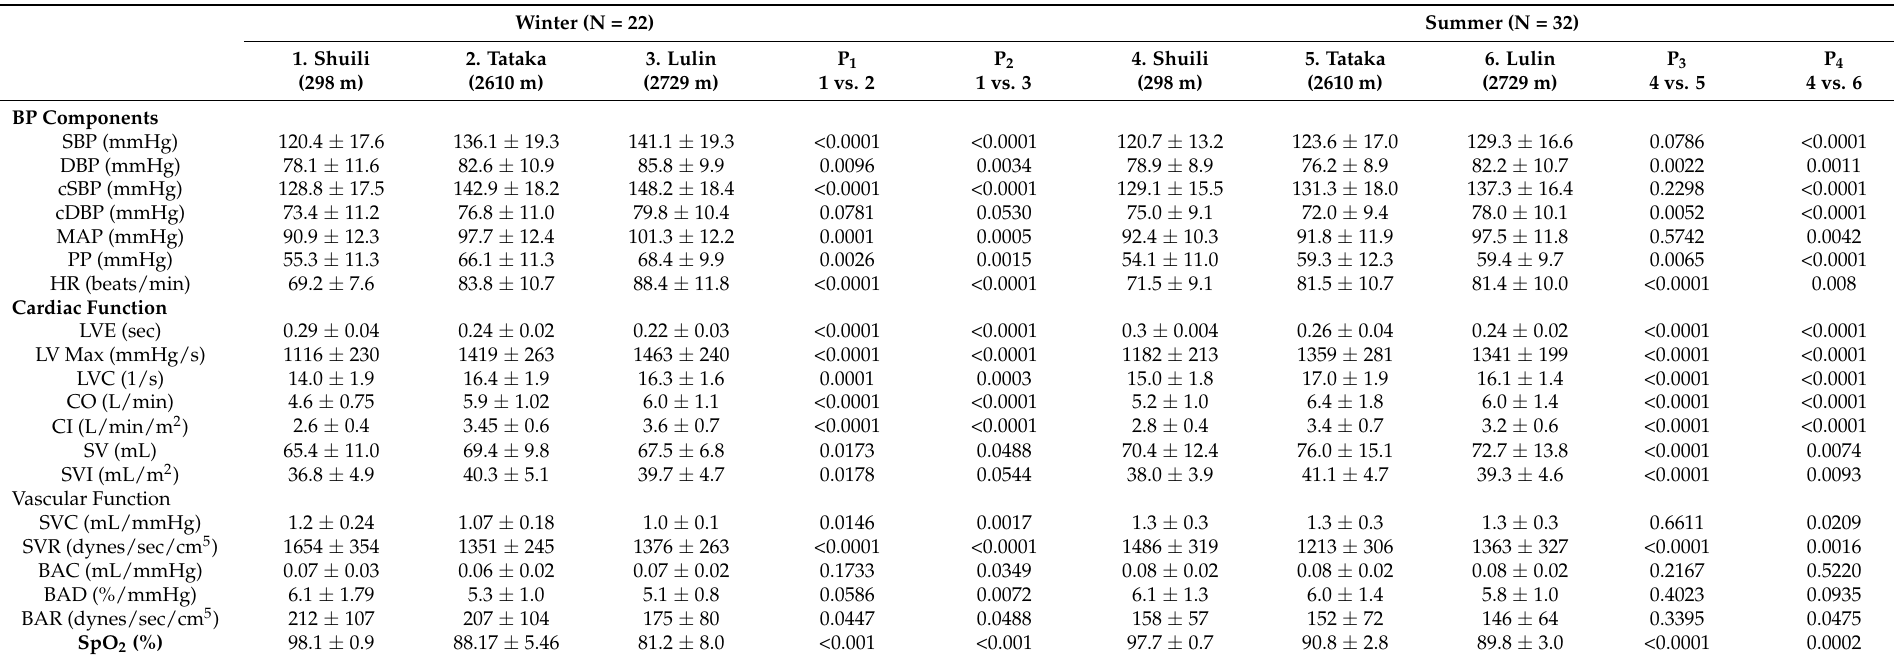
Table 3. Comparisons of cardiac function and hemodynamic parameters ascending from low to high altitude forest in winter and